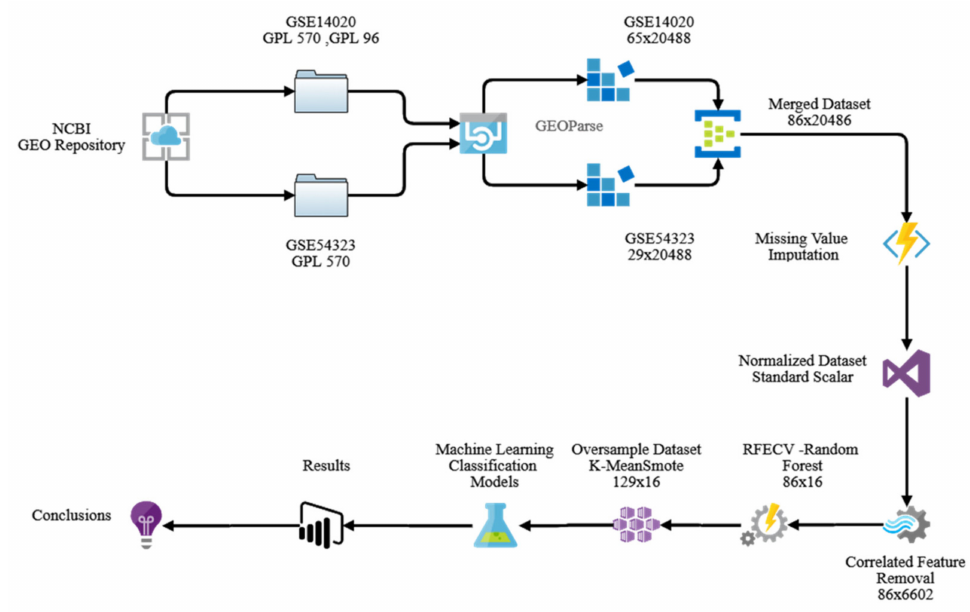
Figure 1. Proposed architecture for identification of breast cancer in vital organs using